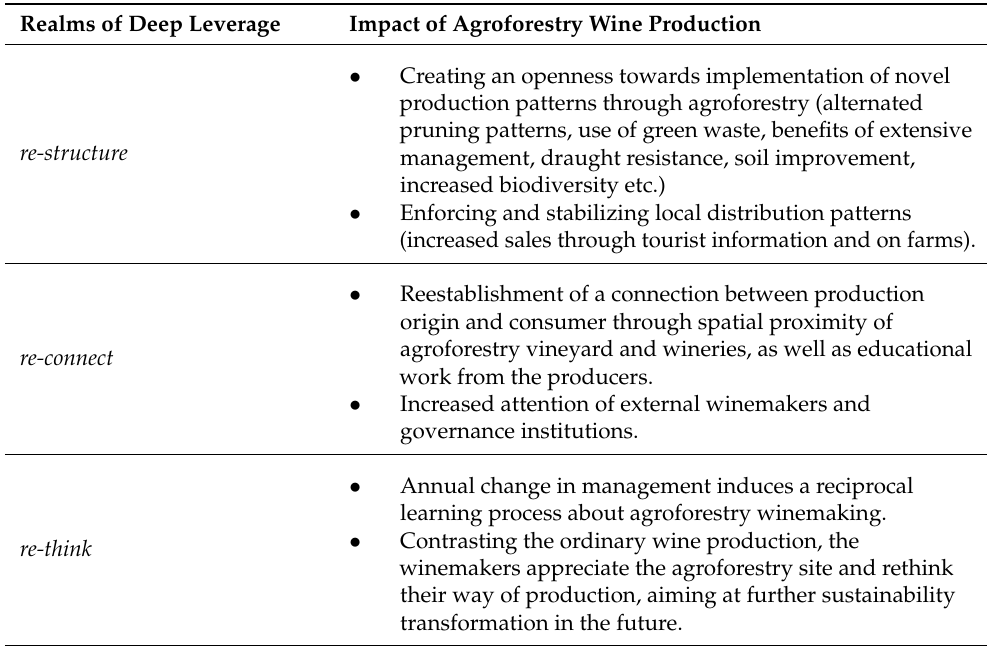
Table 1. Relating Realms of Deep Leverage and Impact of Agroforestry Wine Production. Author’s own